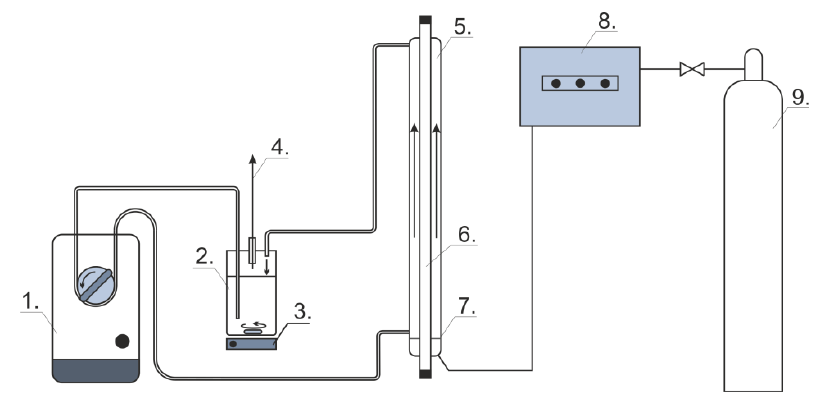
Figure 16. Sketch of the photocatalytic reactor with the auxiliary units: 1, peristaltic pump; 2, buffer vessel; 3, magnetic stirrer; 4, sampling port; 5, reactor (Pyrex vessel); 6, light source; 7, porous sieve; 8, ozone generator; 8, gas